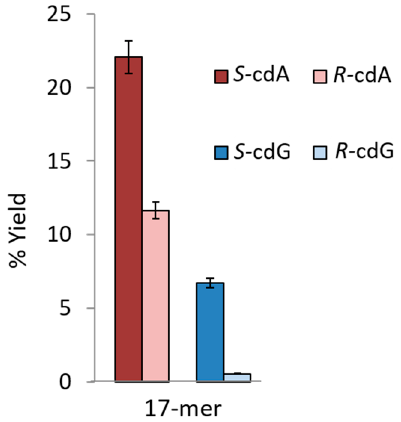
Figure 5. Comparison of the total yields of the 17-mer: 5 ′ -d(CCA CCA AC X CTA CCA CC)-3 ′ , where X = S -cdA, R -cdA, S -cdG, or R -cdG. Table 1. Melting points (Tm) of a series of double-stranded (ds) oligonucleotide sequences. Length